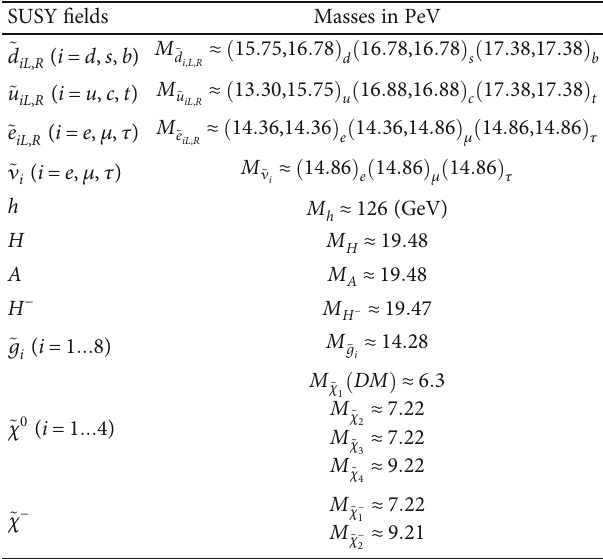
Table 1: Particle mass spectrum after EWSB for the benchmark point given in Table